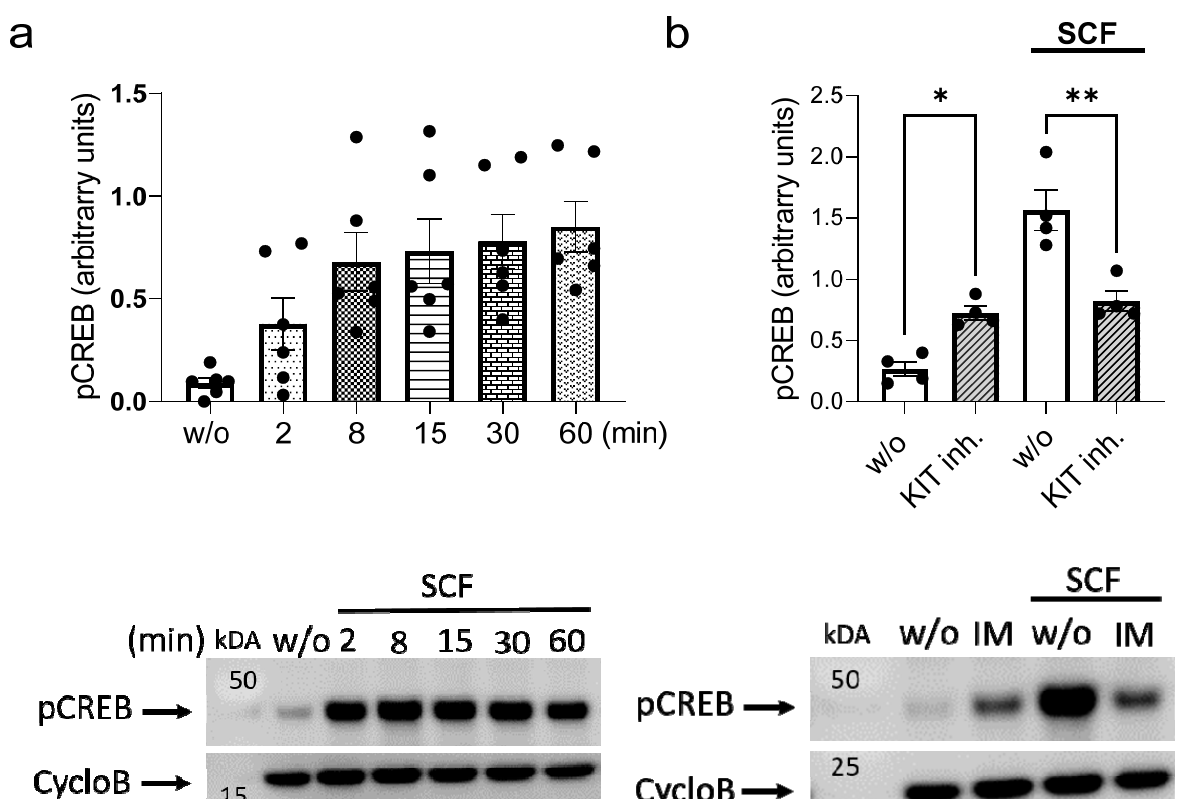
Figure 1. CREB is phosphorylated upon SCF stimulation in a KIT kinase-dependent manner. ( a ) Skin-derived MCs were stimulated with SCF for the indicated times and Ser-133 phosphorylation of CREB was detected by immunoblot in whole-cell lysates. Upper panel: Image J based semi-quantification of the detected signal for pCREB normalized to the housekeeping protein Cyclophilin B (CycloB). Lower panel: Representative time-course. ( b ) Cells were pretreated with imatinib mesylate (KIT inh.) prior to stimulation with SCF for 15 min. Upper and lower panel as in ( a ). Each dot corresponds to one experiment (individual MC culture). * p < 0.05, ** p < 0.01.